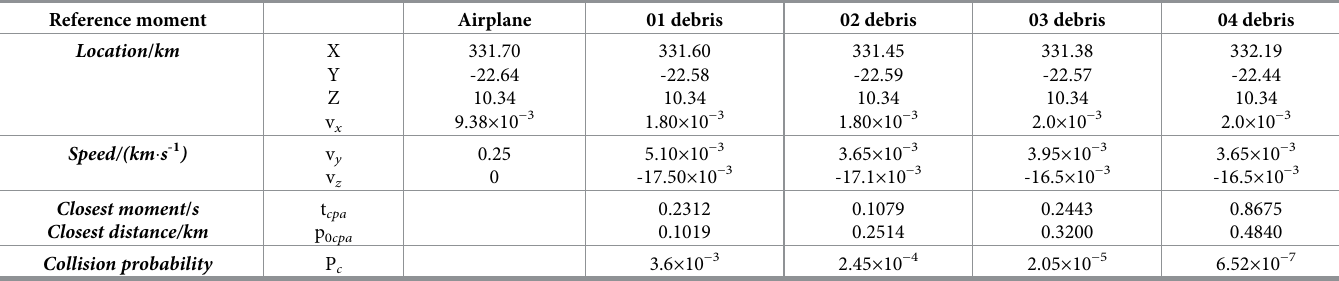
Table 1. Analysis table of the collision probability between the aircraft and different debris at the reference moment.